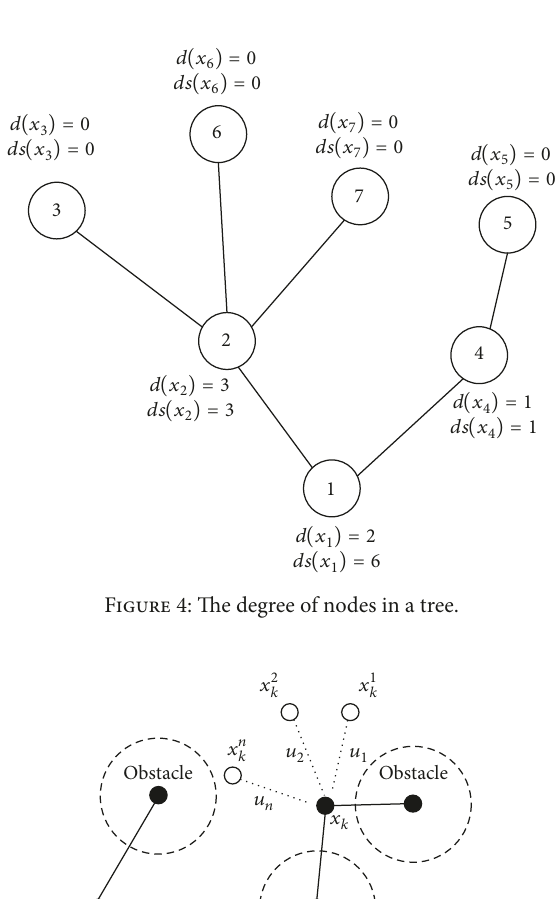
Figure 5: Neighbor obstacles. The radius of neighbor obstacle is generally obtained from